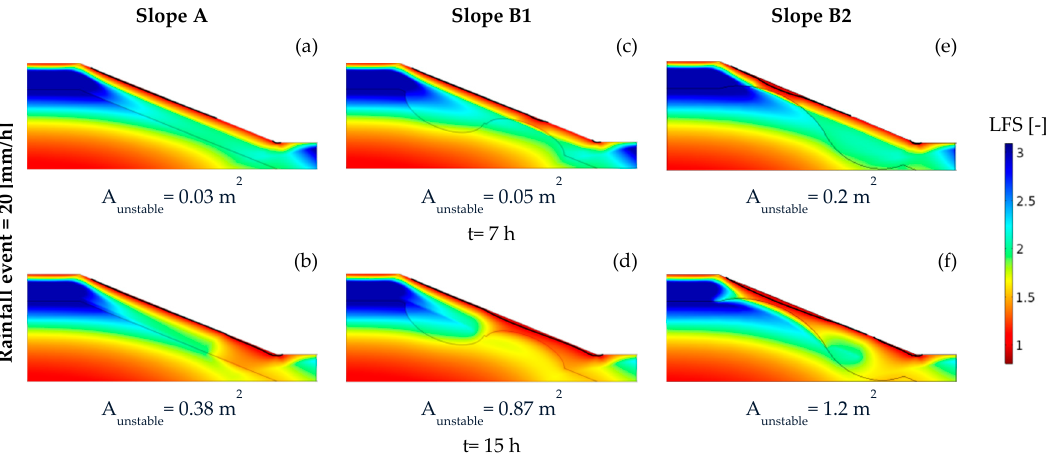
Figure 12. The temporal development of the LFS distribution for a 15-h rainfall event with an intensity of 20 mm per hour for the 2D slope with a constant soil depth (slope A) at ( a ) t = 7 h and ( b ) t = 15 h and the 2D slope with variable soil thickness (Slope B1 and B2) at ( c , e ) t = 7 h and ( d , f ) t = 15 h. Black contour lines indicate areas with LFS < 1.0.